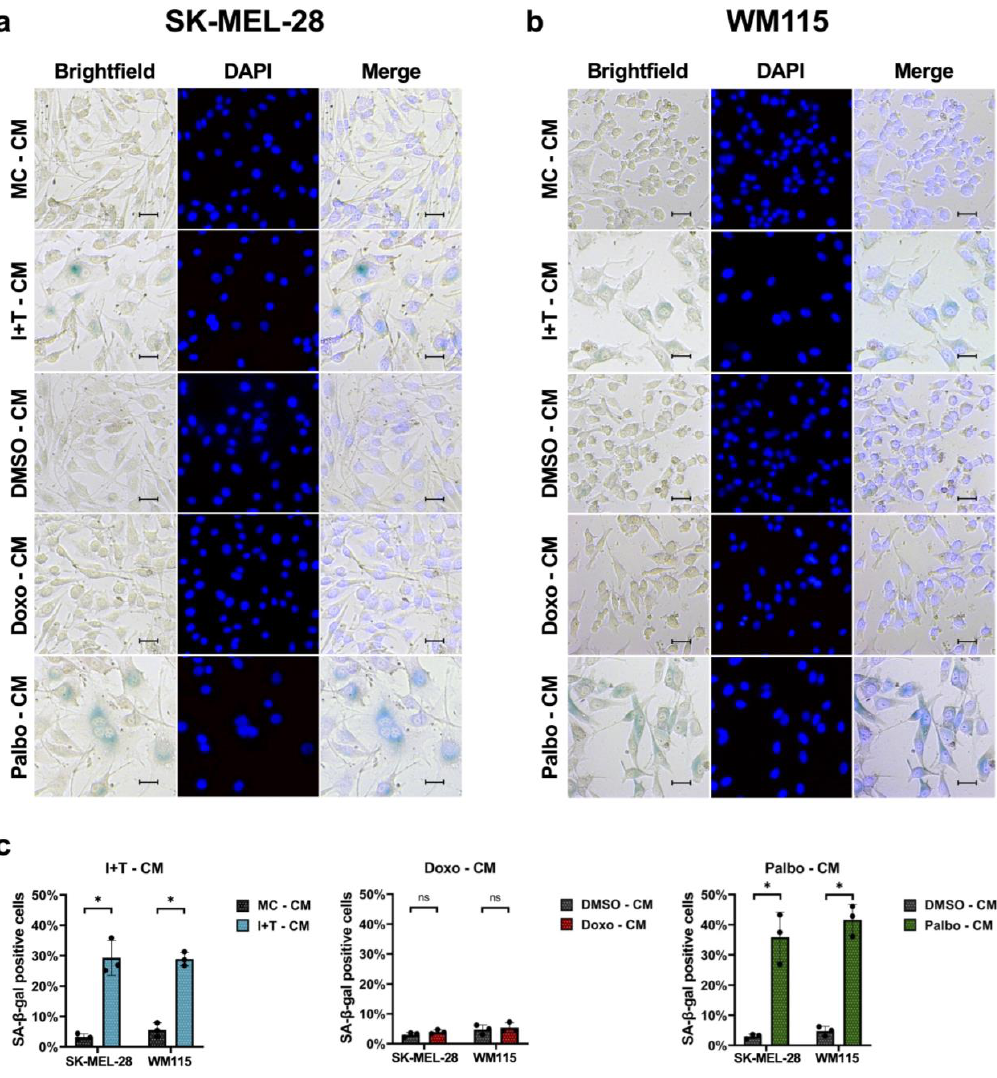
Figure 6. Induction of SA- β -gal activity after treatment with conditioned media (CM) derived from cytokine- and palbociclib-treated SK-MEL-28 and WM115 melanoma cells. ( a ) Representative images of SA- β -gal activity and DAPI staining in SK-MEL-28 ( a ) and WM115 ( b ) cells following treatment with CM for 96 h. Bars = 50 μ m. ( c ) Quantification of SA- β -gal-positive cells. ( a – c ) Results are from three independent experiments ( n = 3); ns, not significant; unpaired Student’s t -test; mean ± s.d.; an asterisk (*) indicates a significant difference from the respective controls with p < 0.05. Taken together, melanoma cells secreted a variety of proinflammatory factors, mainly cytokines, such as IL-1 β and IL-8, and chemokines, such as CXCL10, CXCL11, and CCL20, during CIS, while during TIS, melanoma cells produced lower levels of SASP pro- teins.